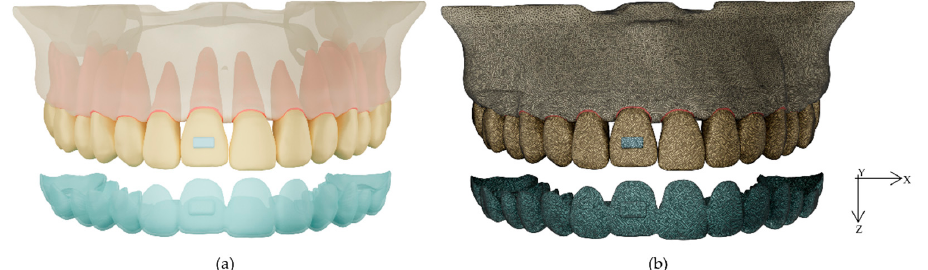
Figure 1. Maxilla model with PDL, upper teeth, clear aligner, and composite attachment: ( a ) 3D model and ( b ) finite element meshing model.